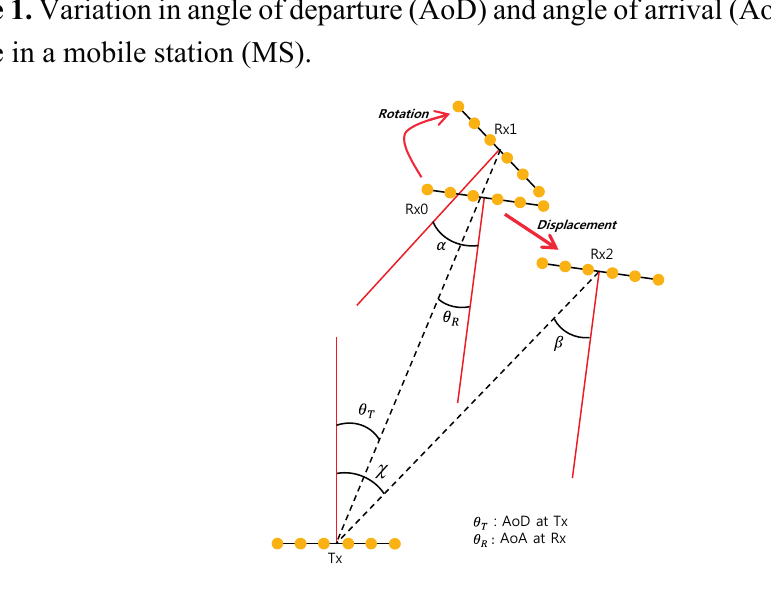
Table 1. Required beam-tracking operation when a behavioral or environmental change occurs. Item Beam-Tracking Rotation Displacement Blocking Characteristics of change Required